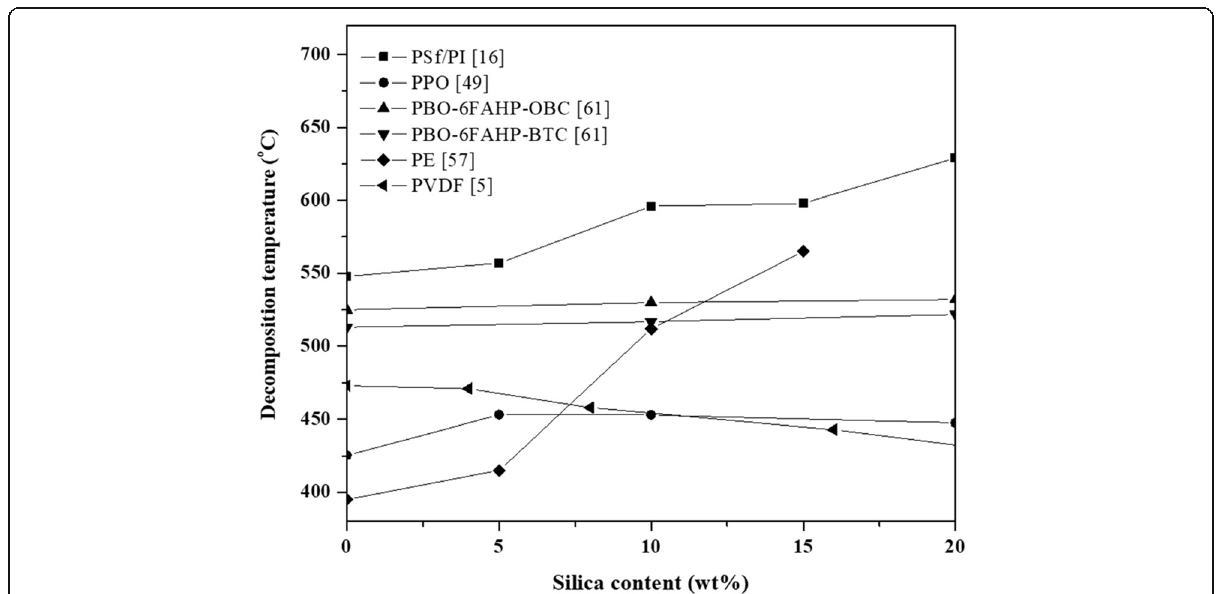
Fig. 10 The enhancement of decomposition temperature of MMMs comprising silica particle (PSf/PI: polysulfone/polyimide; PPO: polyphenylene oxide; PBO-6FAH-OBC: (polybenzoxazole) – (2,2-bis 3-amino-4-hydro-xyphenyl hexafluoropropane) – (4,4 ′ -oxybis benzoic acid chloride); PBO-6FAH- BTC: (polybenzoxazole) – (2,2-bis 3-amino-4-hydro-xyphenyl hexafluoropropane) – (1,3,5-benzenetricarbonyltrichloride); PE: polyethylene; PVDF: polyvinylidene